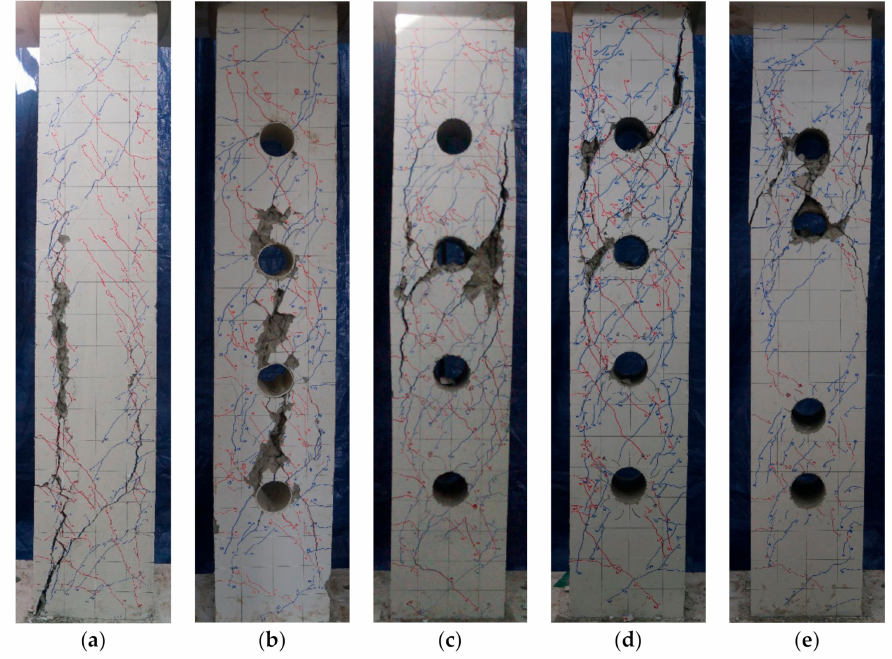
Figure 6. Crack patterns of specimens at failure: ( a ) No. 1; ( b ) No. 2; ( c ) No. 3; ( d ) No. 4; ( e ) No. 5.